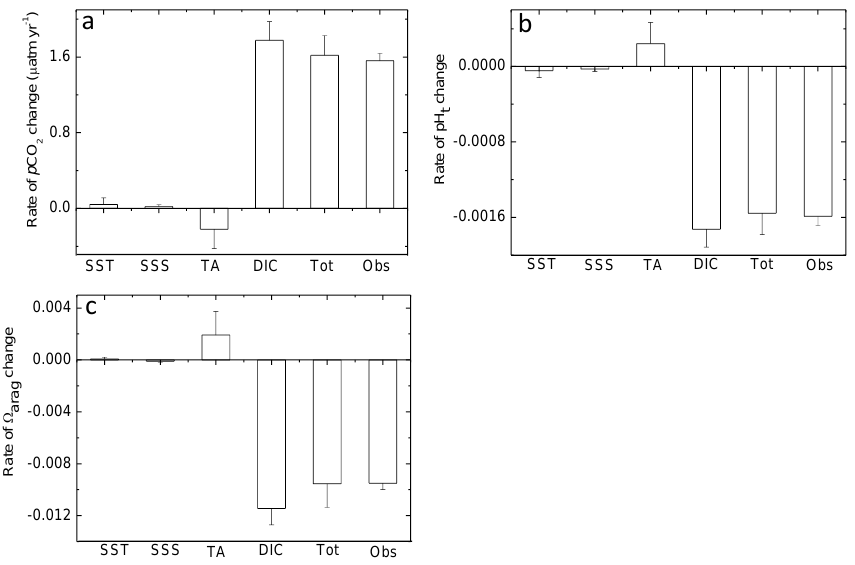
Figure 8. Contribution of SST, SSS, TA and DIC to the change of p CO 2 (a) , pH t (b) , and aragonite saturation state, (cid:127) arag (c) . Tot denotes the sum of the decomposed individual contributions and Obs the observed trend.